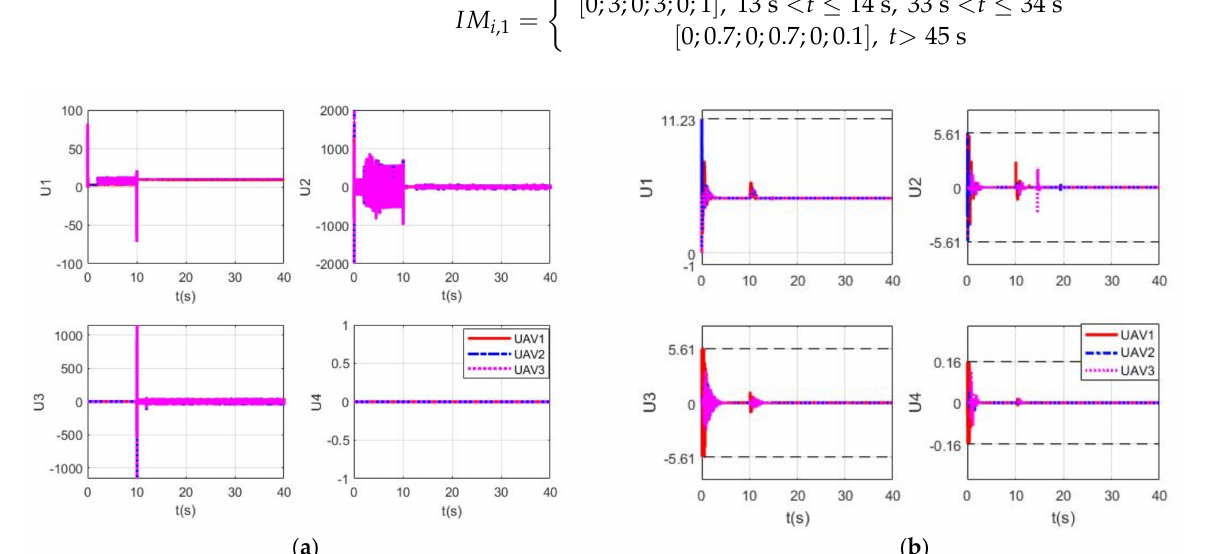
Figure 8. Inputs for UAVs with SMC ( a ) and MPC ( b ). The SMC requires aggressive control and may suffer from oscillation to achieve a desirable performance of formation. However, IMPC enables the optimal performance of control and formation while ensuring the physical constraints of the quadrotors.